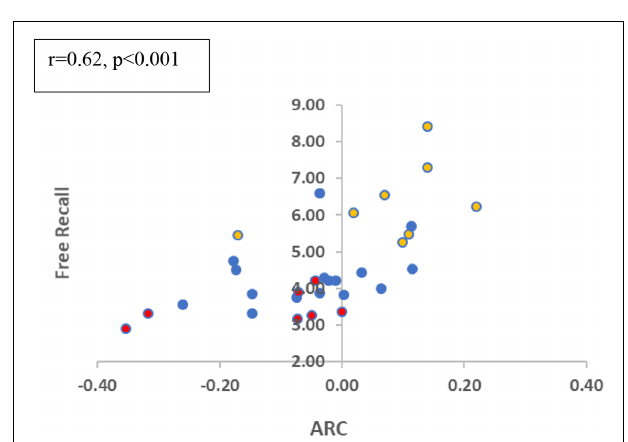
FIGURE 3 | ARC scores of the three age groups (blocks 2 + 3 collapsed; error bars correspond to standard errors of the mean).